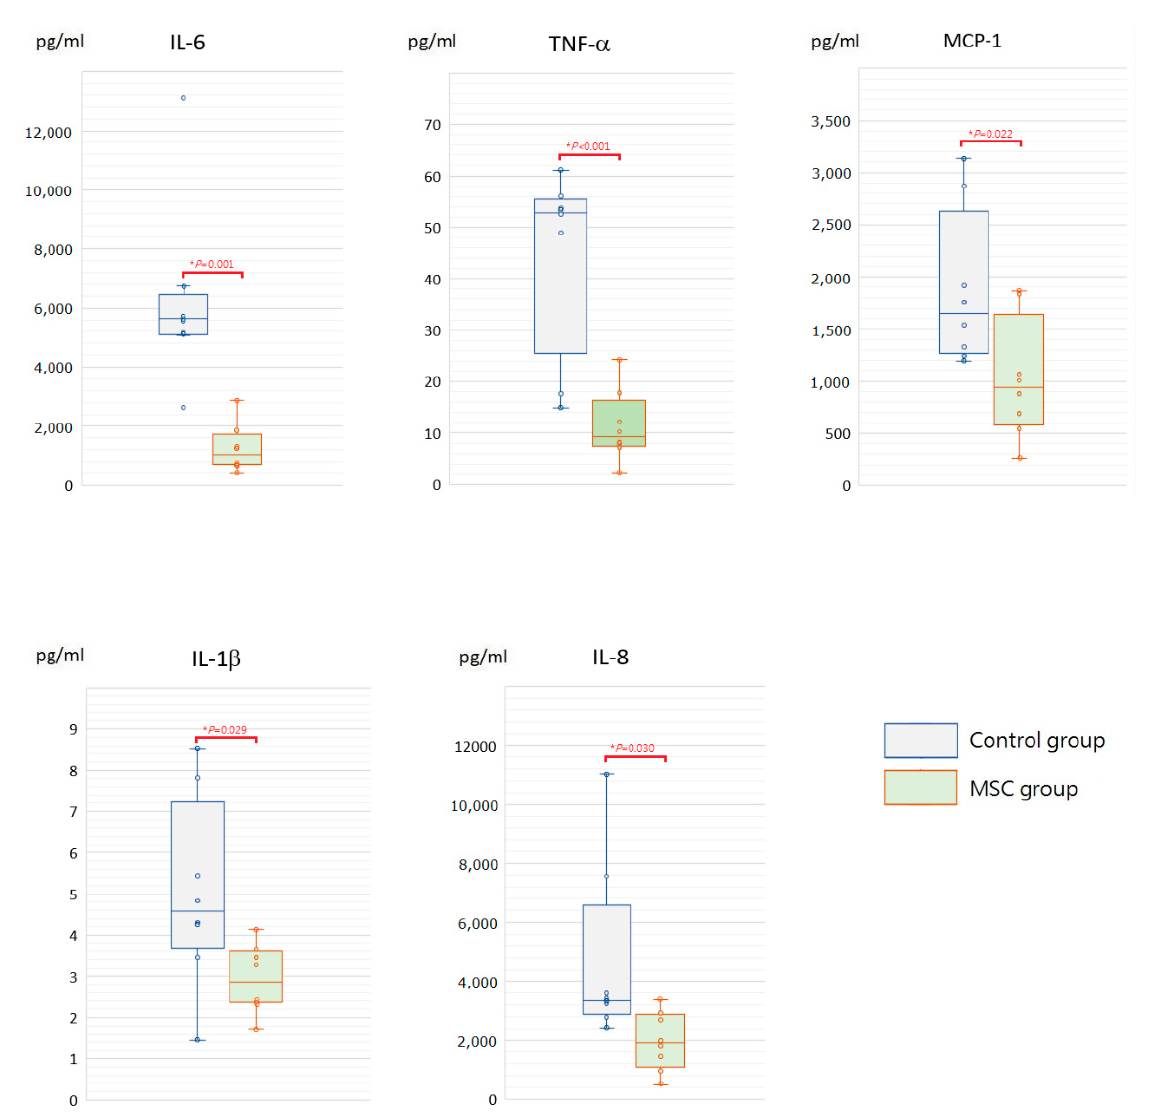
Figure 2. Boxplots of serum inflammatory cytokine levels at 6 h after LPS-induced ALI. Compared to the control group, serum levels of IL-6, TNF- α , MCP-1, IL-1 β , and IL-8 were significantly decreased in the MSC group. The box is drawn from the first quartile to the third quartile with a horizontal line in the middle to denote the median. The whiskers extending from the box indicate variability outside the upper and lower quartiles. Each circle represents the concentration of each animal. n = 8 mice/group.